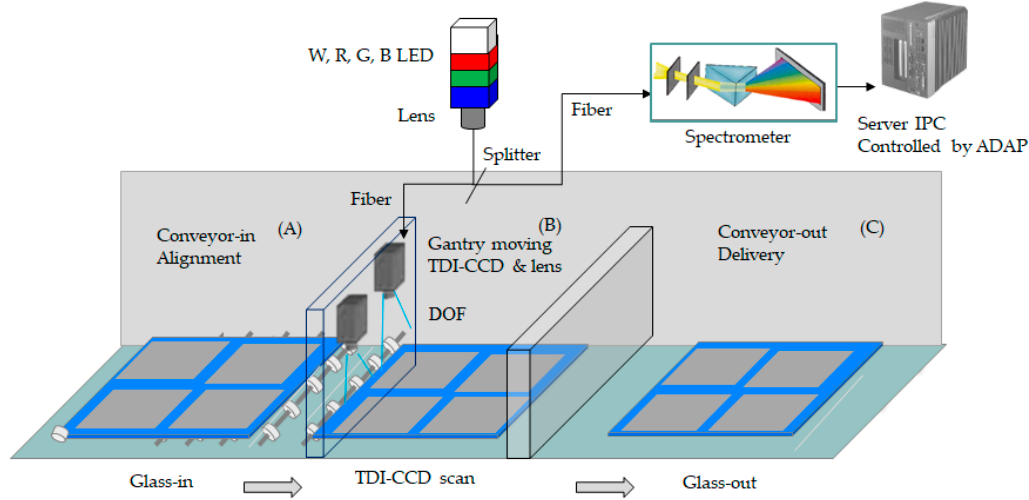
Figure 1. A sequent process of the thin-film transistor (TFT) glass in the architecture of automatic optical inspection. In which ( A ) is the alignment and conveyor-in, ( B ) is the captured image site, and ( C ) is the conveyor-out.